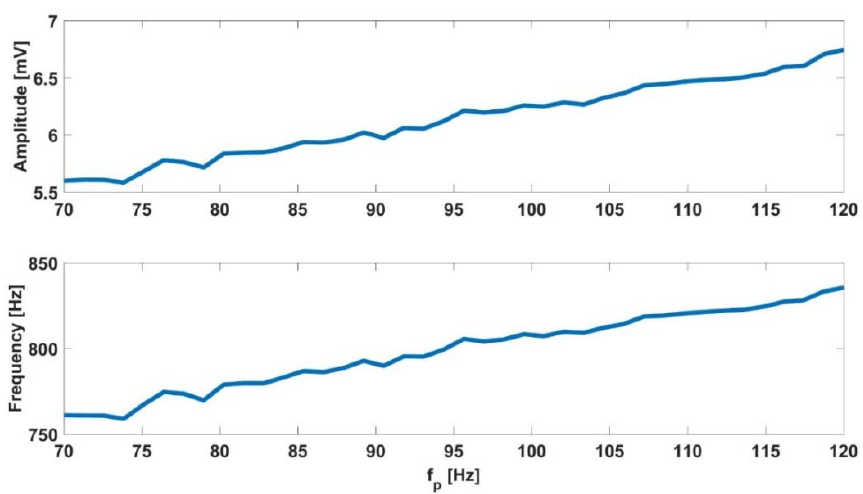
Figure A2. Variation of initial oscillation amplitude and frequency as a function of the pole position f p .